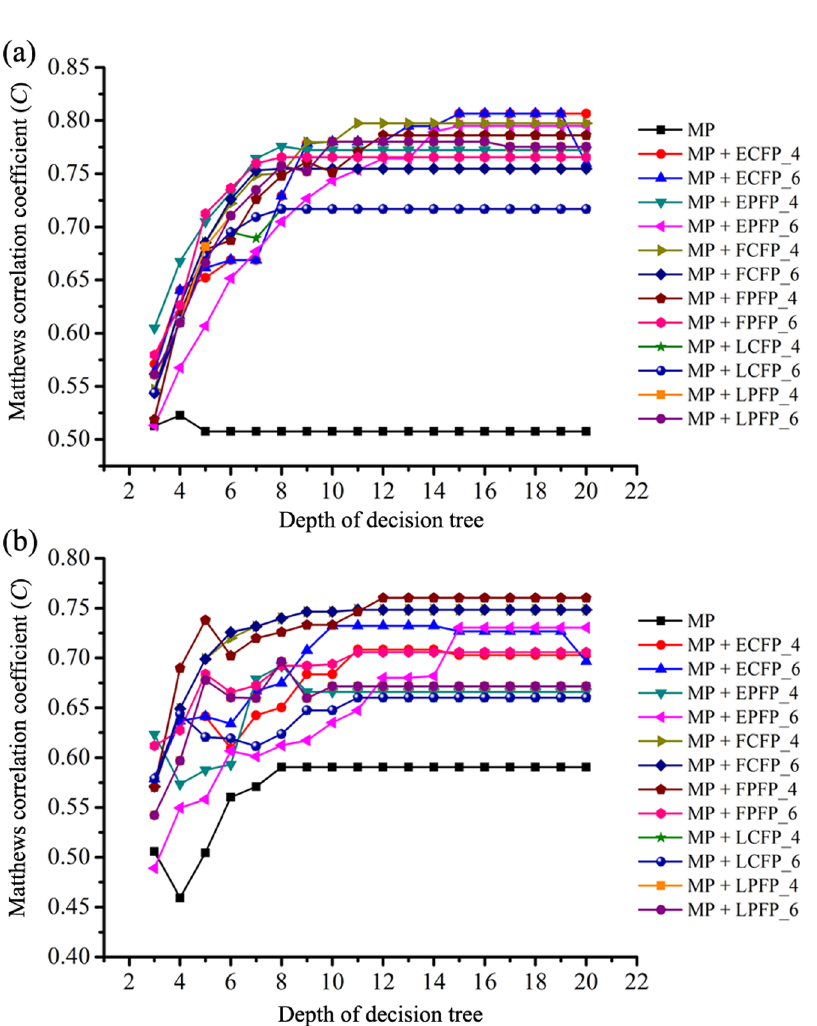
Figure 4. The Matthews correlation coefficient ( C ) versus the tree depth for (a) the training set and (b) the test set. The 243 RP models were constructed based on molecular properties (thirteen molecular descriptors) and the different combinational of molecular properties and twelve different fingerprint sets.